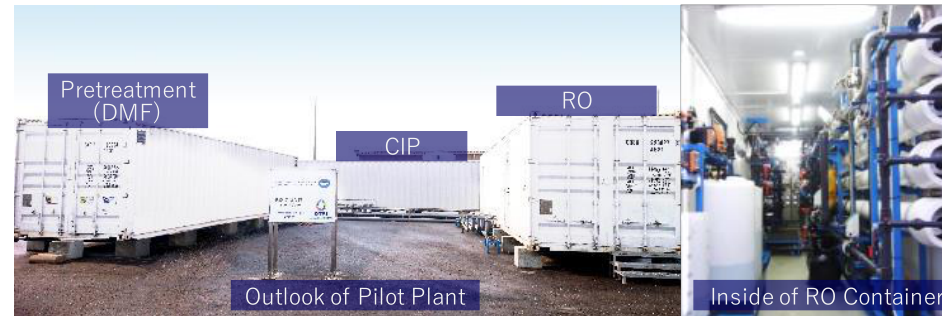
Figure 1. System schematics of the pilot plant.